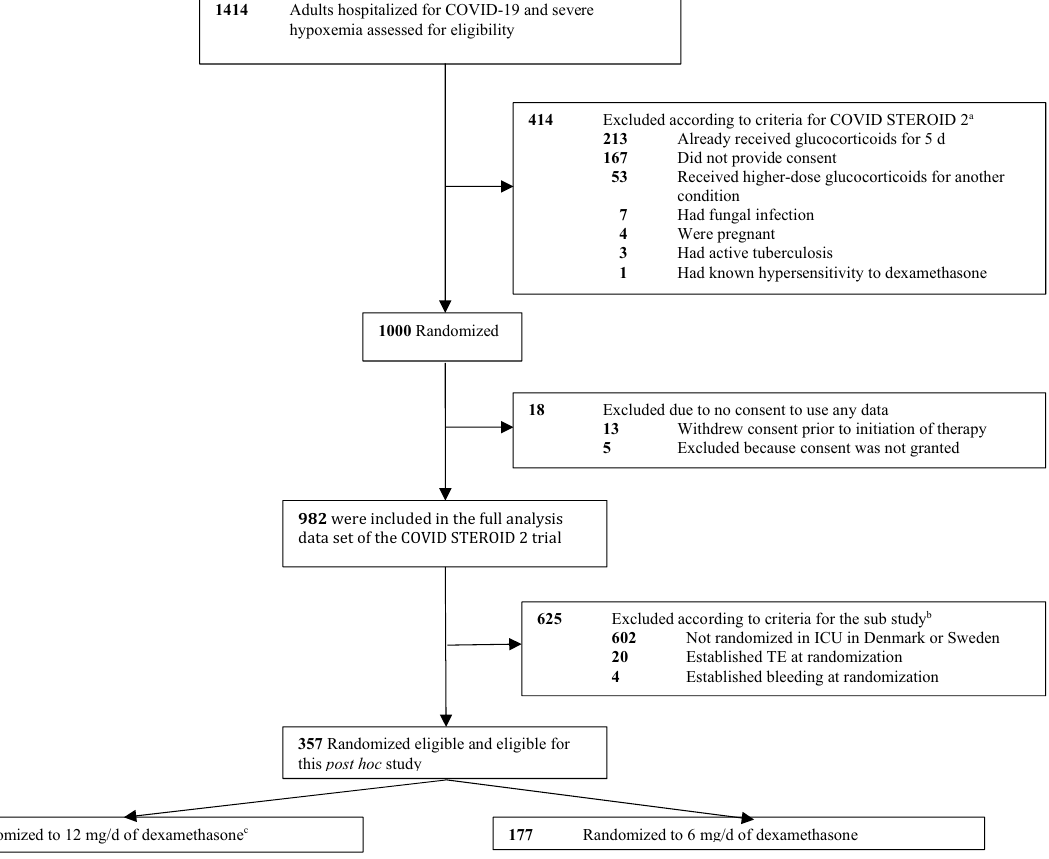
Table 2). The cumulative proportions of death or TE